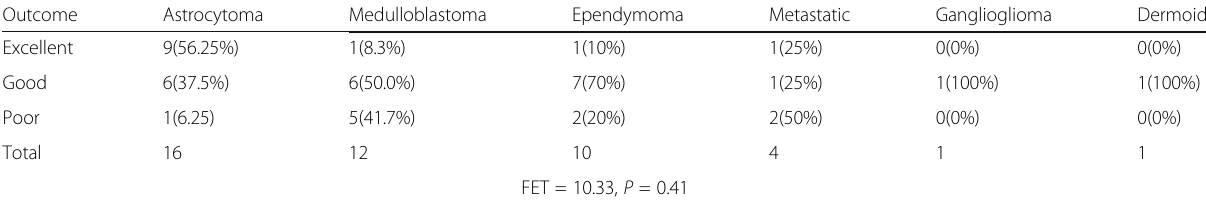
Table 4 Outcome of different types of posterior fossa brain tumours